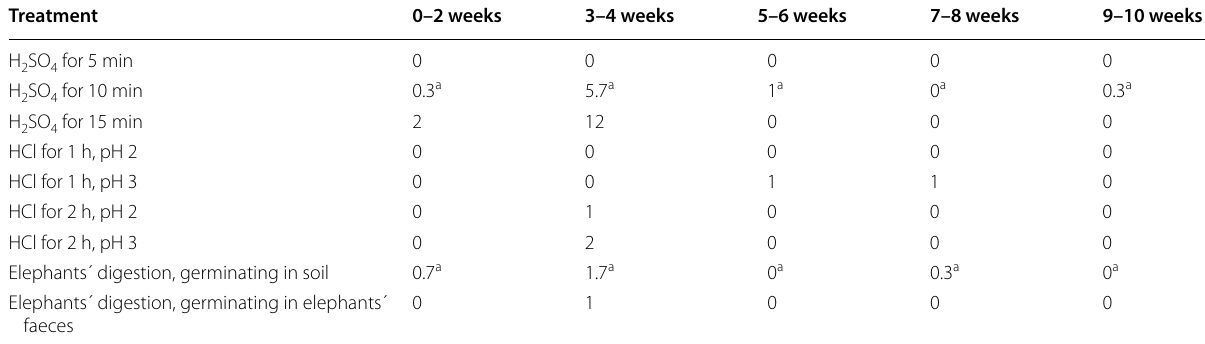
Numbers marked with a are the average of the germination tests (2017, 2018, 2019) the remaining numbers are obtained in the test sets in 2018 or 2019